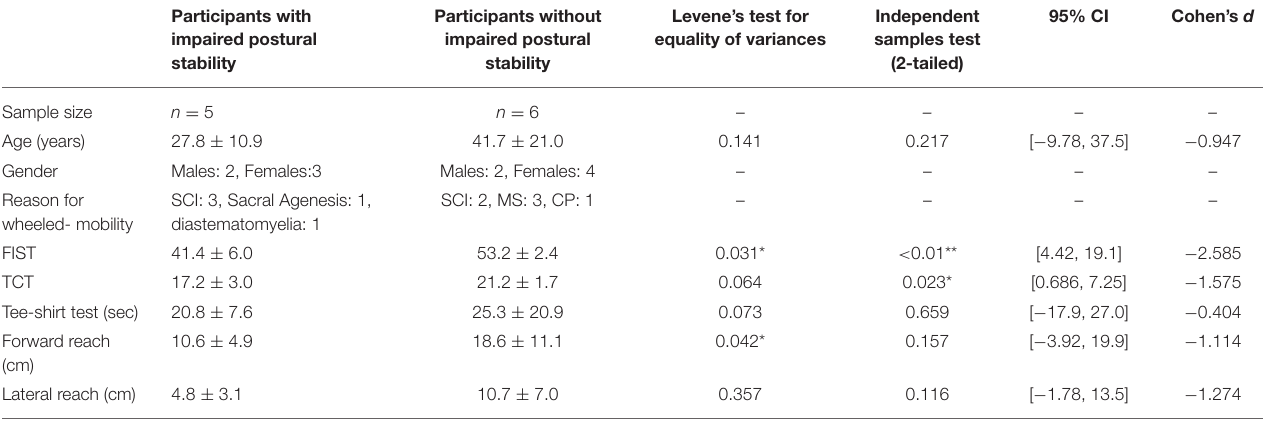
TABLE 5 | Participant demographic information.